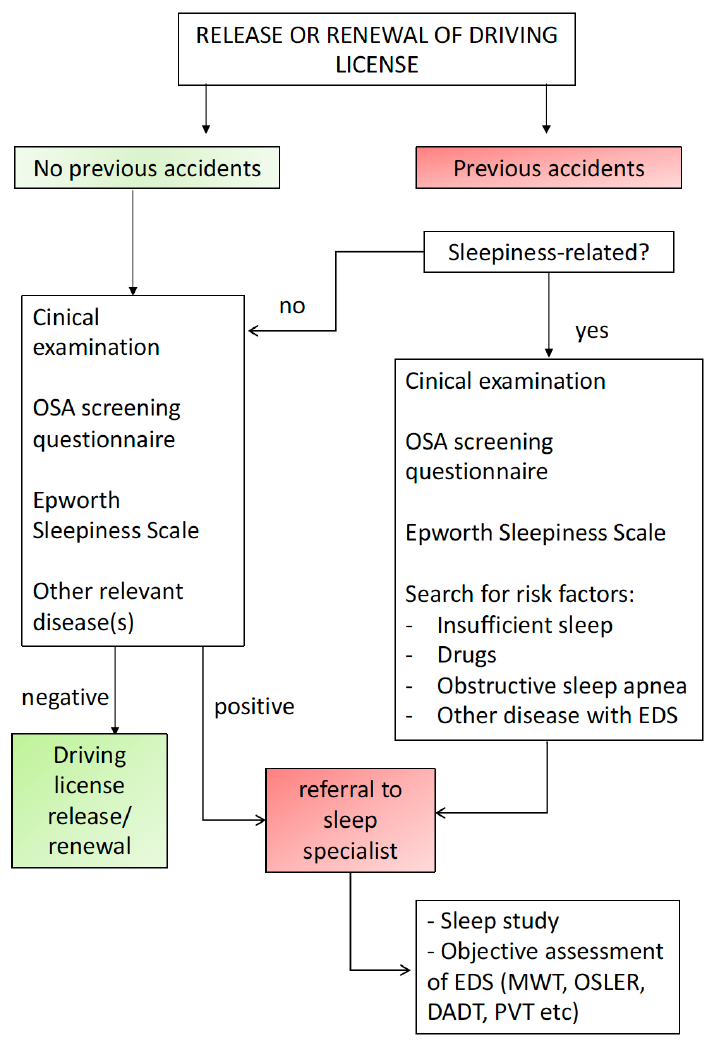
Figure 1. Proposed flowchart to be used for driving license release or renewal. Occurrence of previous sleepiness-related car accidents should be thoroughly investigated. Abbreviations: OSA: Obstructive Sleep Apnea; EDS: Excessive Daytime Sleepiness; MWT: Maintenance of Wakefulness Test; DADT: Divided Attention Driving Task; PVT: Psychomotor Vigilance Test. From [10] with permission.